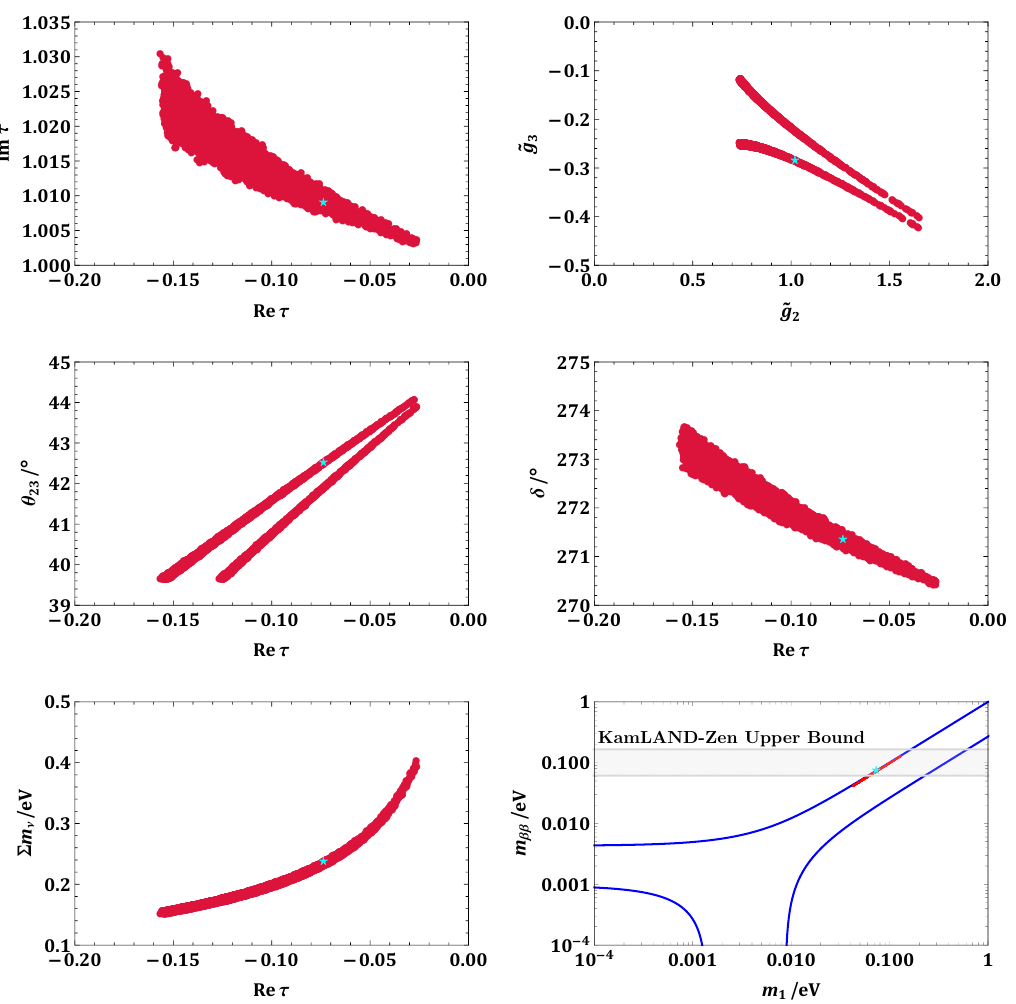
Figure 1 . The allowed parameter space of the model parameters { Re τ, Im τ, observables at the 3 σ level in the NO case, where the cyan stars denote the best-fit values from the χ 2 -fit analysis. The gray shaded region in the bottom-right panel represents the upper bound on from the KamLAND-Zen experiment [58], and the blue boundary is obtained by using the 3 σ m ββ ranges of { θ , θ } and { ∆ m 2 , ∆ m 2 } from the global-fit 12 13 21 31